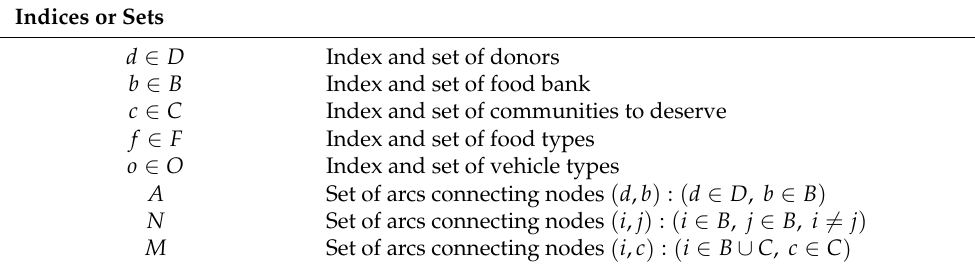
Table 2. Sets and indices used in the model formulation.